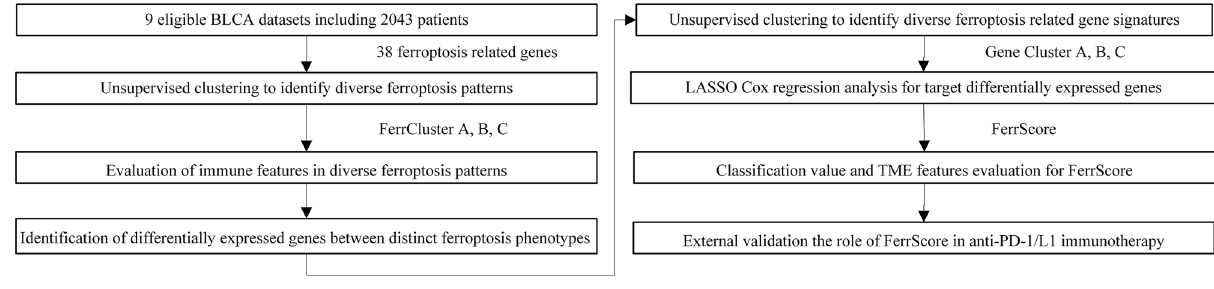
Figure 1. The flow diagram of our main